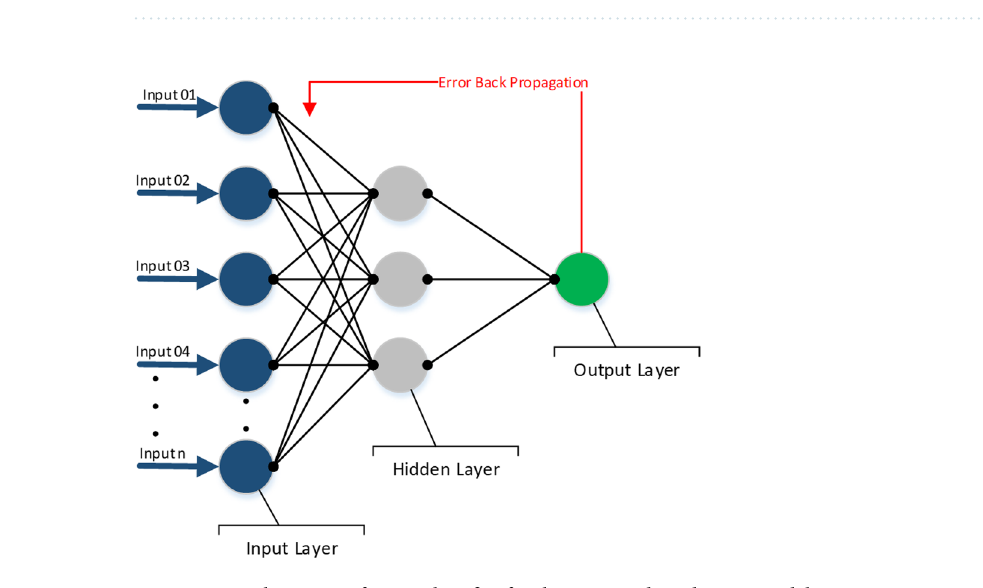
Figure 3. Architecture of random forest classifier for the proposed prediction model.